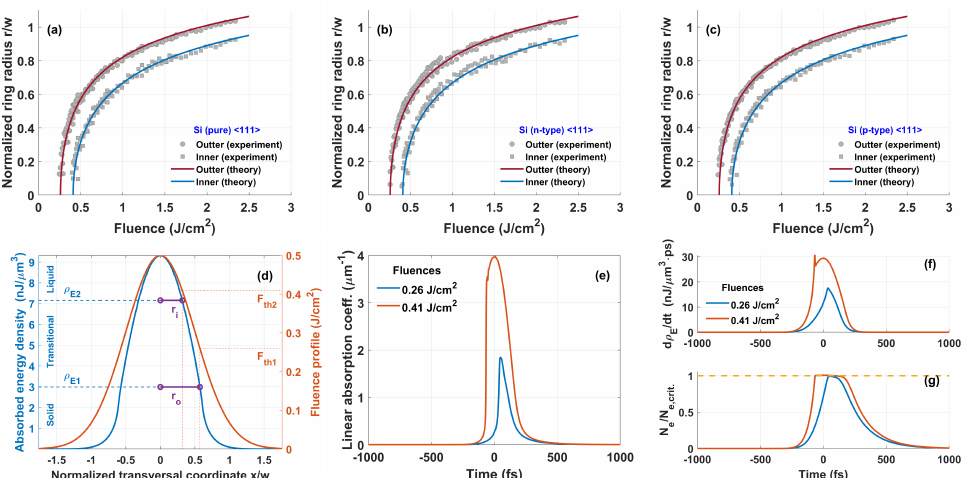
Figure 4. The inner and outer radii dependence on the fluence for ( a ) pure, ( b ) n-type, and ( c ) p-type silicon. Points correspond to the experimental measurements. The solid lines calculated numerically for τ c = 64.6 fs, τ R = 161 fs, and β = 18.0 cm/GW. ( d ) Absorbed energy density on the surface across the beam. ( e ) Effective absorption coefficient α , ( f ) energy density absorption rate, and ( g ) electron concentration on the crystal surface for two limiting fluence values F 1 and F 2